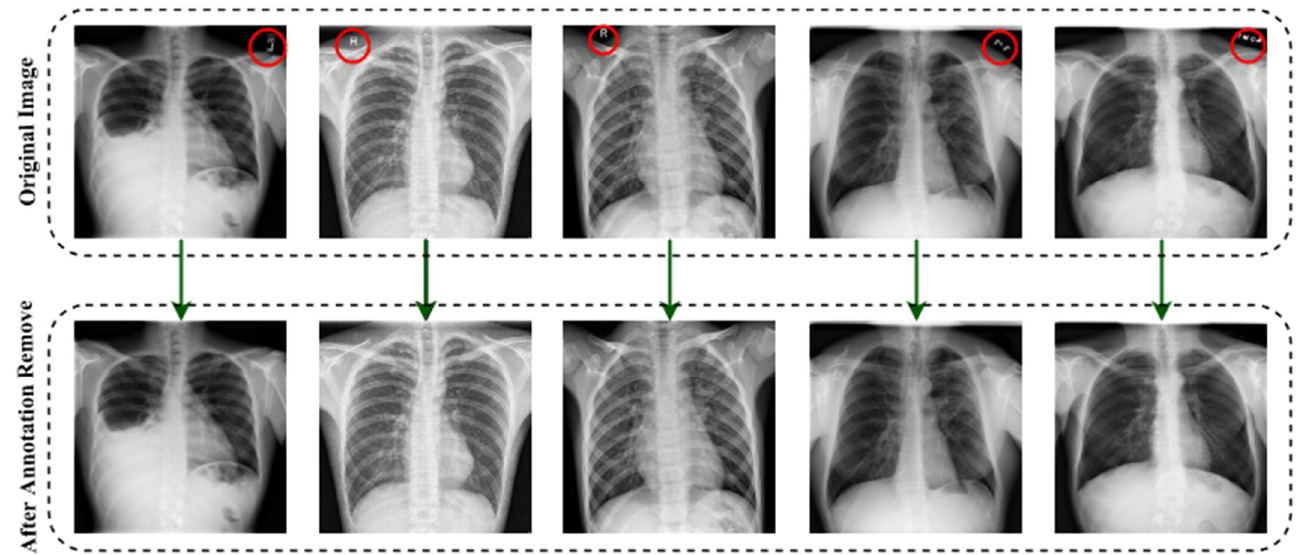
Figure 4. The output after deploying the image annotation removal method.